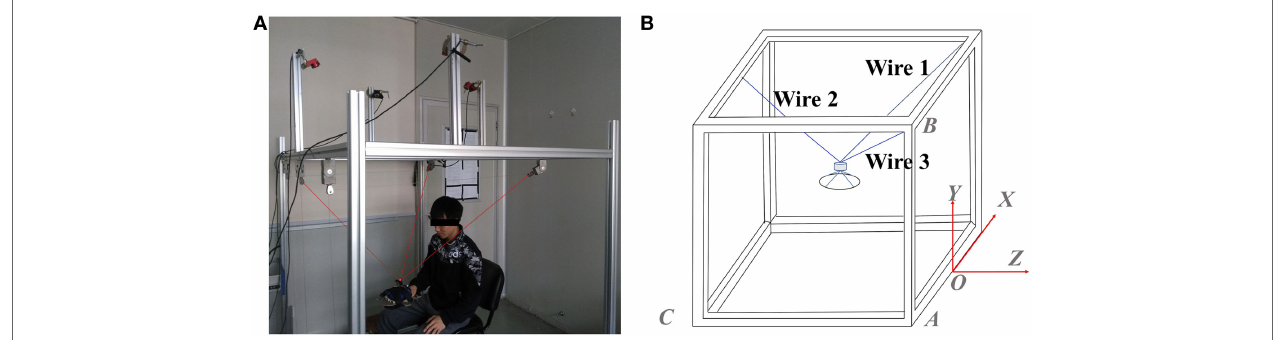
FIGURE 1 | A wire-driven rehabilitation robot. (A) Mechanical architecture of the wire-driven rehabilitation robot and (B) geometry of the wire-driven rehabilitation robot.